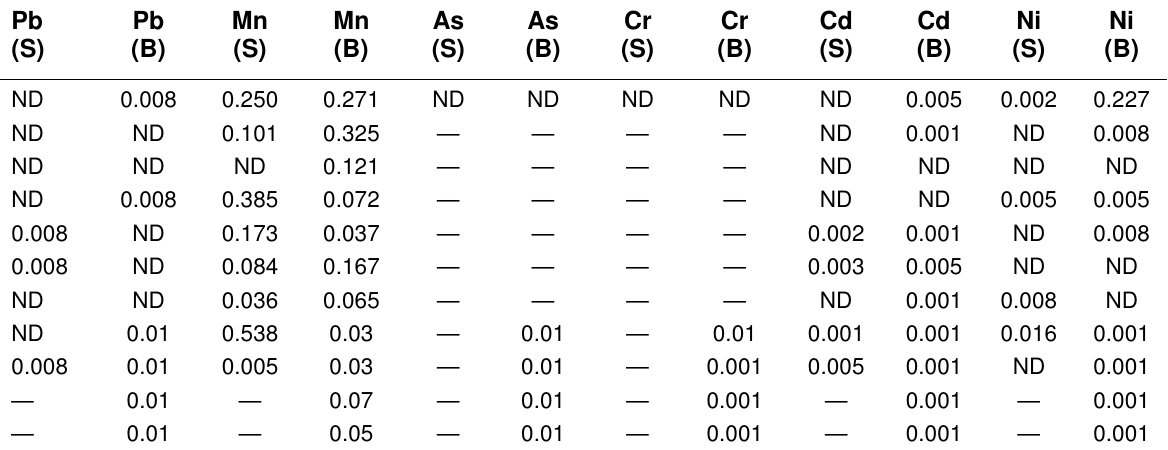
Concentration of Heavy Metals (mg/l) of Shallow/Hand Dug (S) and Borehole (B) Well Water